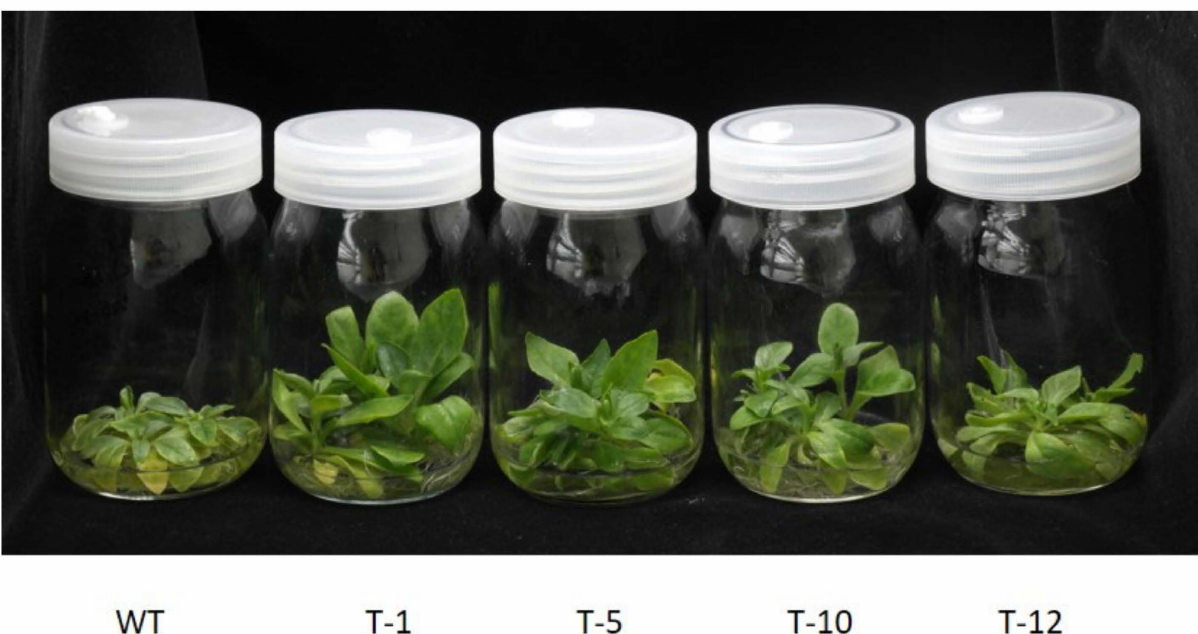
Figure 4. Comparison of plant growth status of WT and transgenic petunia cv. ‘Mirage Rose’ plants under cadmium (Cd) stress conditions. This image was taken on the 30th day of the experiment.